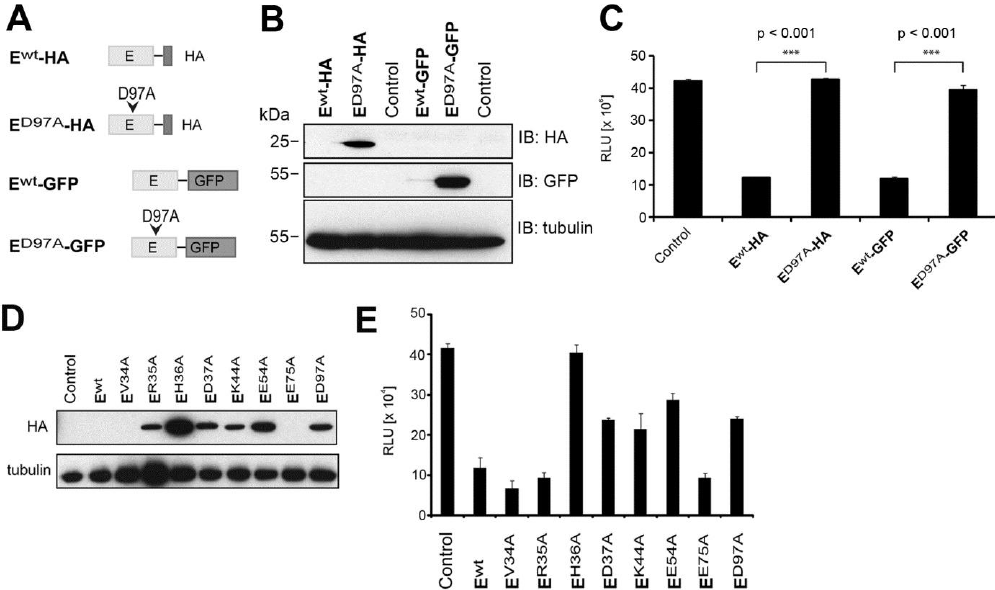
Figure 2. Mutational analysis of HTNV endonuclease domain. ( A ) Schematic representation of the constructs. ( B ) BSR T7/5 cells were transfected with wild-type (wt) or D97A HTNV L protein N-terminal constructs along with an nanoluciferase (NLuc) reporter control plasmid. Cells were lyzed 48 h post-transfection. Proteins were separated by sodium dodecyl sulfate-polyacrylamide gel electrophoresis (SDS-PAGE) and transferred on membranes for immunoblotting. ( C ) NLuc activity was measured using the Nano Glow ® Luciferase Assay System (Promega). Data represent mean ± SD ( n = 3). One representative experiment out of three is shown. Data were analyzed using one-way ANOVA with p-values indicated. ( D ) BSR T7/5 cells were co-transfected with HA-tagged WT L protein N-terminal constructs and the indicated mutants together with an NLuc reporter plasmid. Cells were lyzed 48 h post-transfection and HA-tagged endonuclease constructs detected in Western blot. ( E ) Nanoluciferase activity was measured using the Nano Glow ® Luciferase Assay System (Promega). Data represent mean ± SD ( n = 3). One representative experiment out of three is shown. Data were analyzed using one-way ANOVA with p -values *** p < 0.001, The significant difference with mutant E75A ( p < 0.05) was not consistently observed between independent experiments.